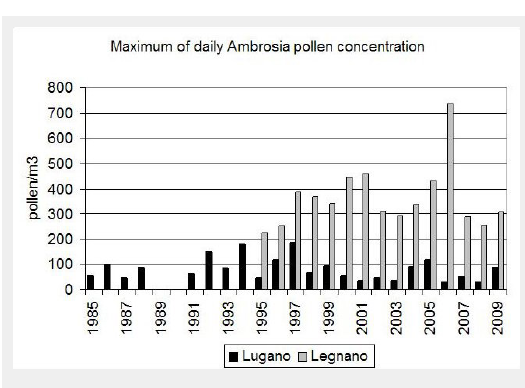
Figure 4 Maximum values of the daily pollen concentration in Legnano and